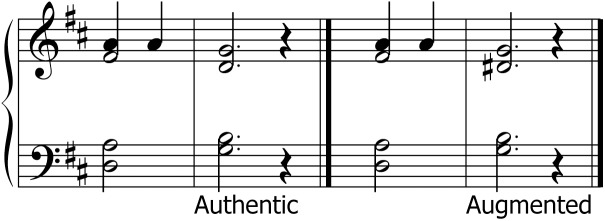
Exemplary score of the two final bars of a song harmonization, containing an authentic V-I cadence and a cadence ending with an augmented chord (right).